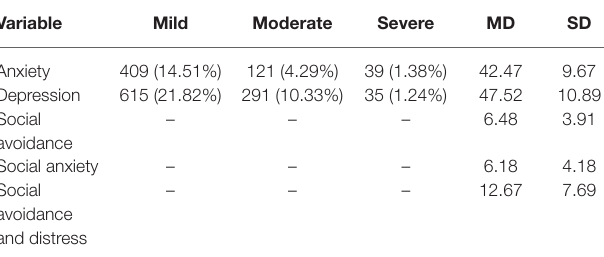
TABLE 2 | Descriptive analysis of mental health